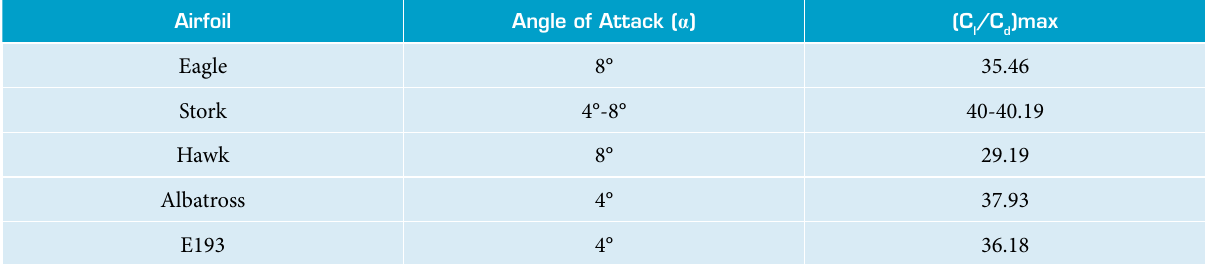
Figure 7. Aerodynamics efficiency of the studied airfoils. Table 4. (C /C ) max for the studied l d